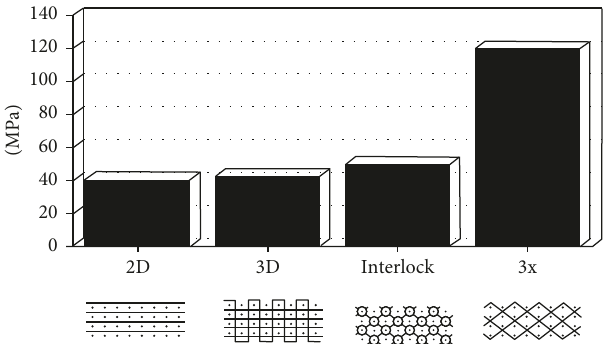
Figure 5: Influence of textile pattern on the interlaminar shearing tests for rupture mode type II [54].